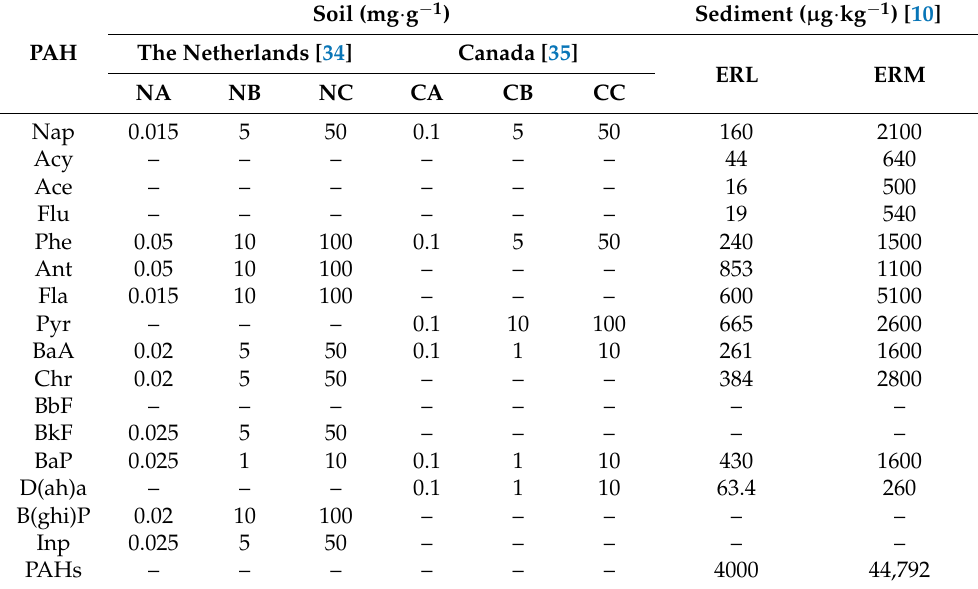
Table 1. Target values of PAHs in the soils and sediments across the globe.